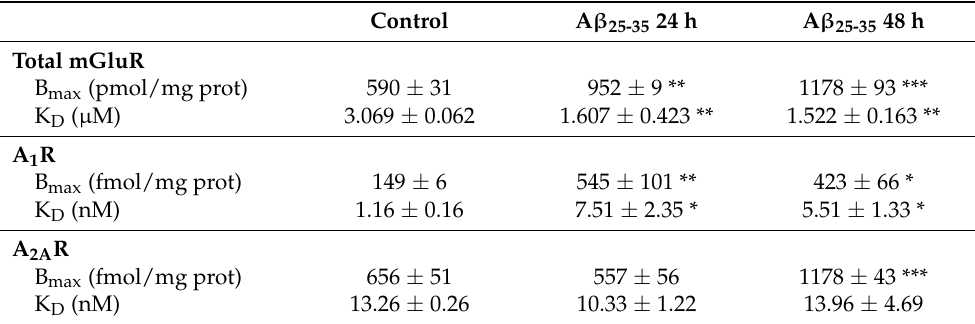
Table 1. A β 25-35 exposure effect on receptors density and affinity in cortical